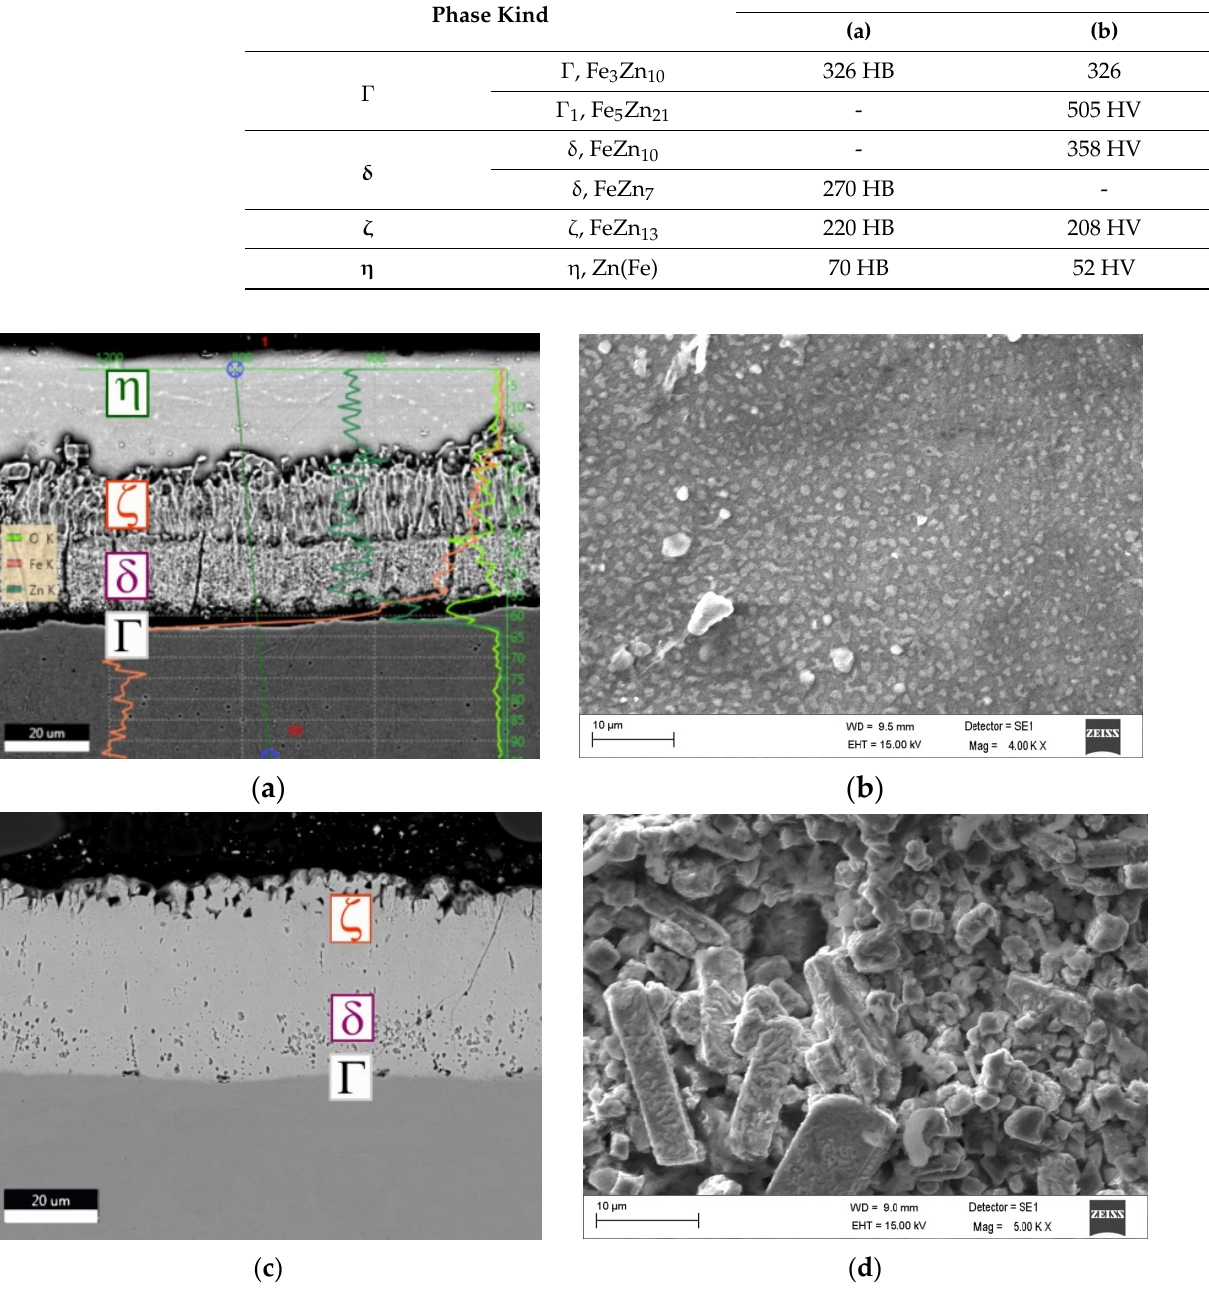
Figure 2. The microstructure observed in the cross section ( a , c ) and on the outer surface of zinc coating deposited on heads bolts ( b , d ) ( a , b —without HT; c , d —t = 430 °C, τ = 11 min). Table 3. The content of iron in individual intermetallic phases of the zinc coating, deposited by ho-dip zinc galvanizing, according to: J. D. Culcasi et al. [54] ( a ), D. Kopyci ń ski et al. [56] ( b ) and H. Kania et al. [57] ( c ).